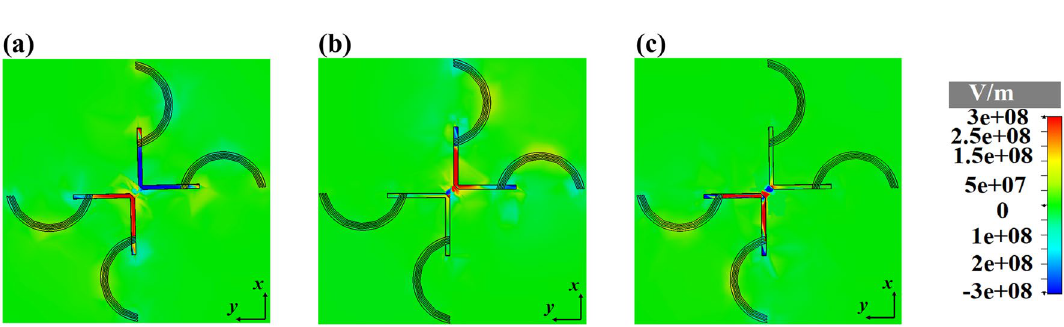
Figure 14. The distributions of the z-component of electric field of smart quad-directional cross dipole nano- antenna at 1550 nm for different states of chemical potential ( a ) µ 1 = µ 2 = 0 eV , ( b ) µ 1 = 0 eV , µ 2 = 0.51eV and ( c ) µ 1 = 0 .51eV , µ 2 = 0 eV